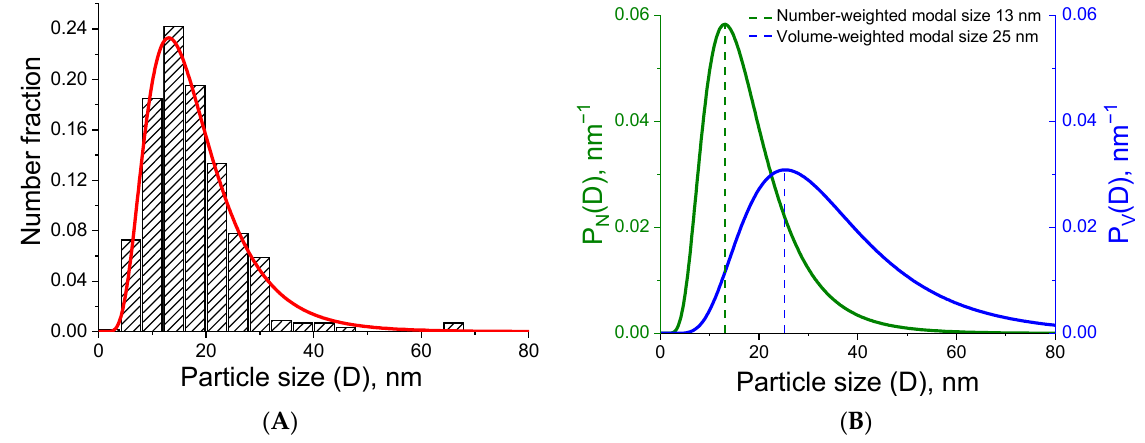
Figure 5. Histogram representing the size distribution of a number fraction of individual particles fitted by a log-normal distribution ( A ) and the normalized number-weighted P N (D) and volume-weighted P V (D) probability density functions ( B ).